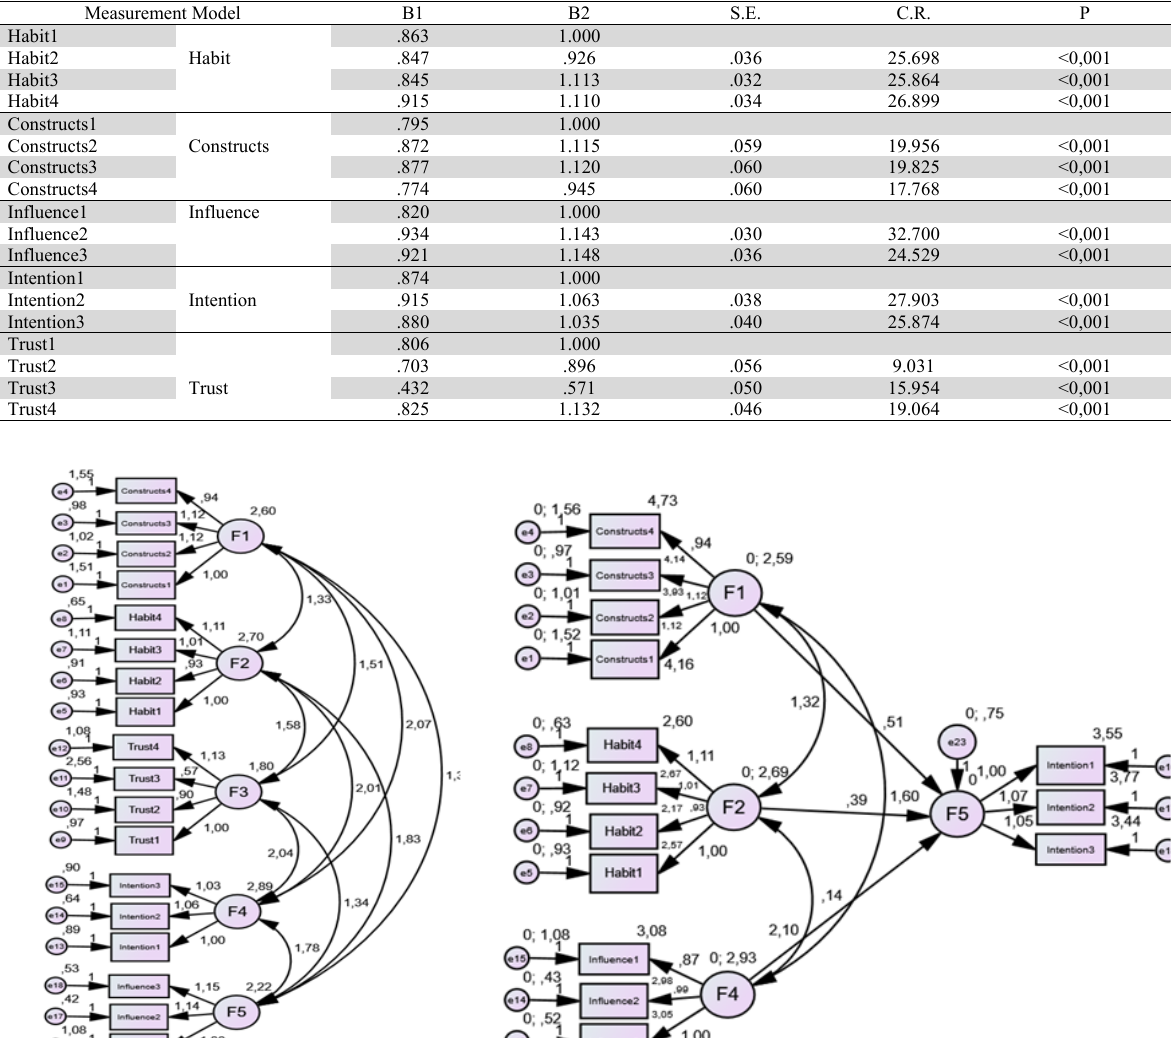
Statistical Data on Path Coefficients